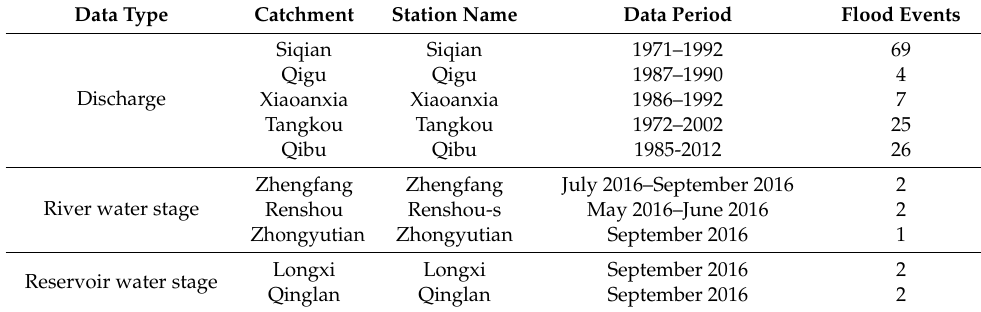
Table 2. Available hydrometeorological